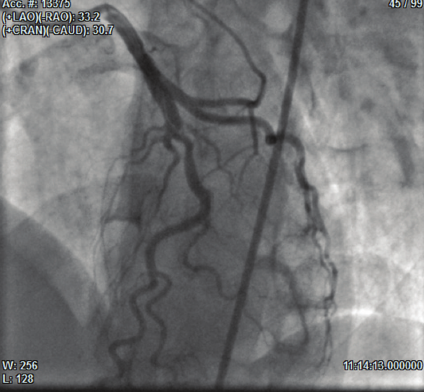
Figure 4: (33 ∘ LAO and 30 ∘ CRA): angiographic control at day 25 showing reopened